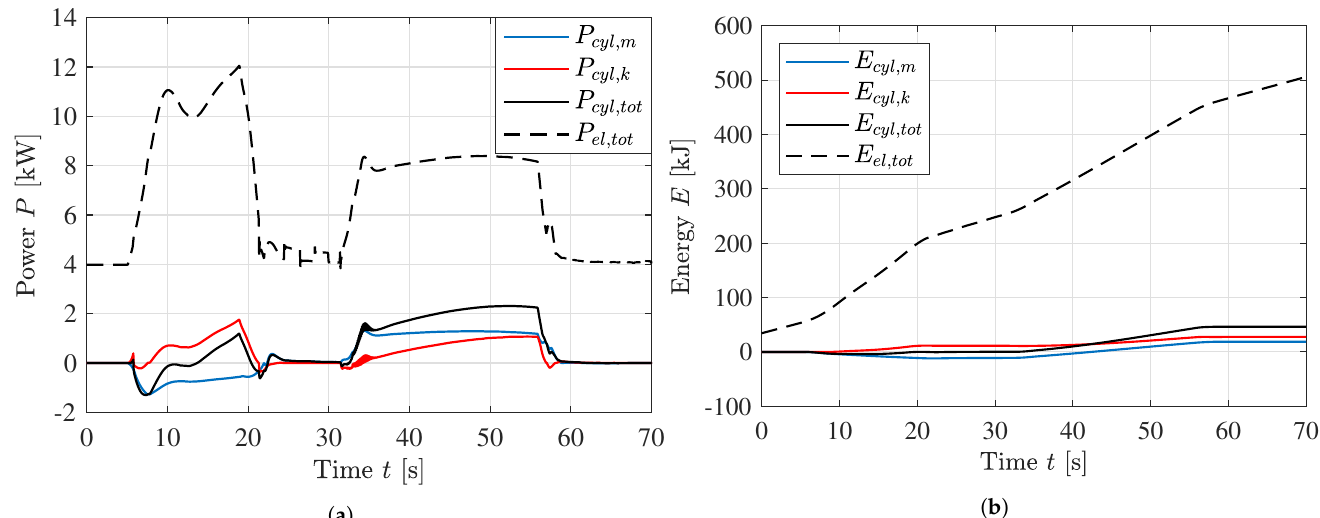
Figure 30. Power and energy during motion with valve-controlled actuators. ( a ) Power from the grid and to the cylinders; ( b ) Consumed energy with valve-controlled actuators.